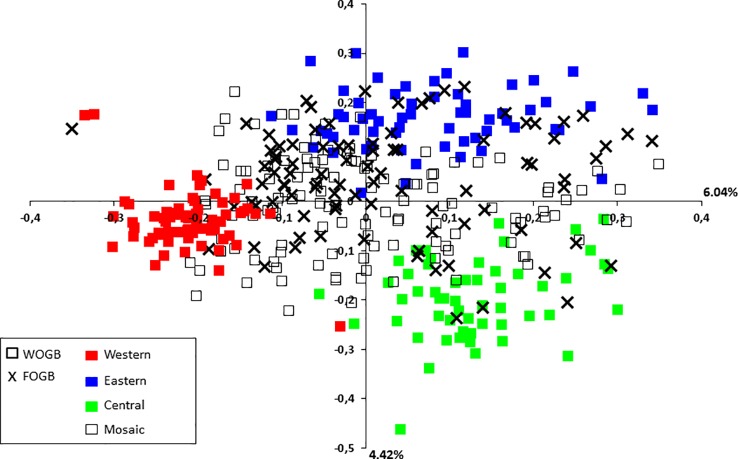
Two-dimensional distribution of the principal coordinates analysis (PCoA) for the 395 distinct genotypes from both collections. Gene pools as identified by for genotypes of the WOGB collection are shown by different colors.